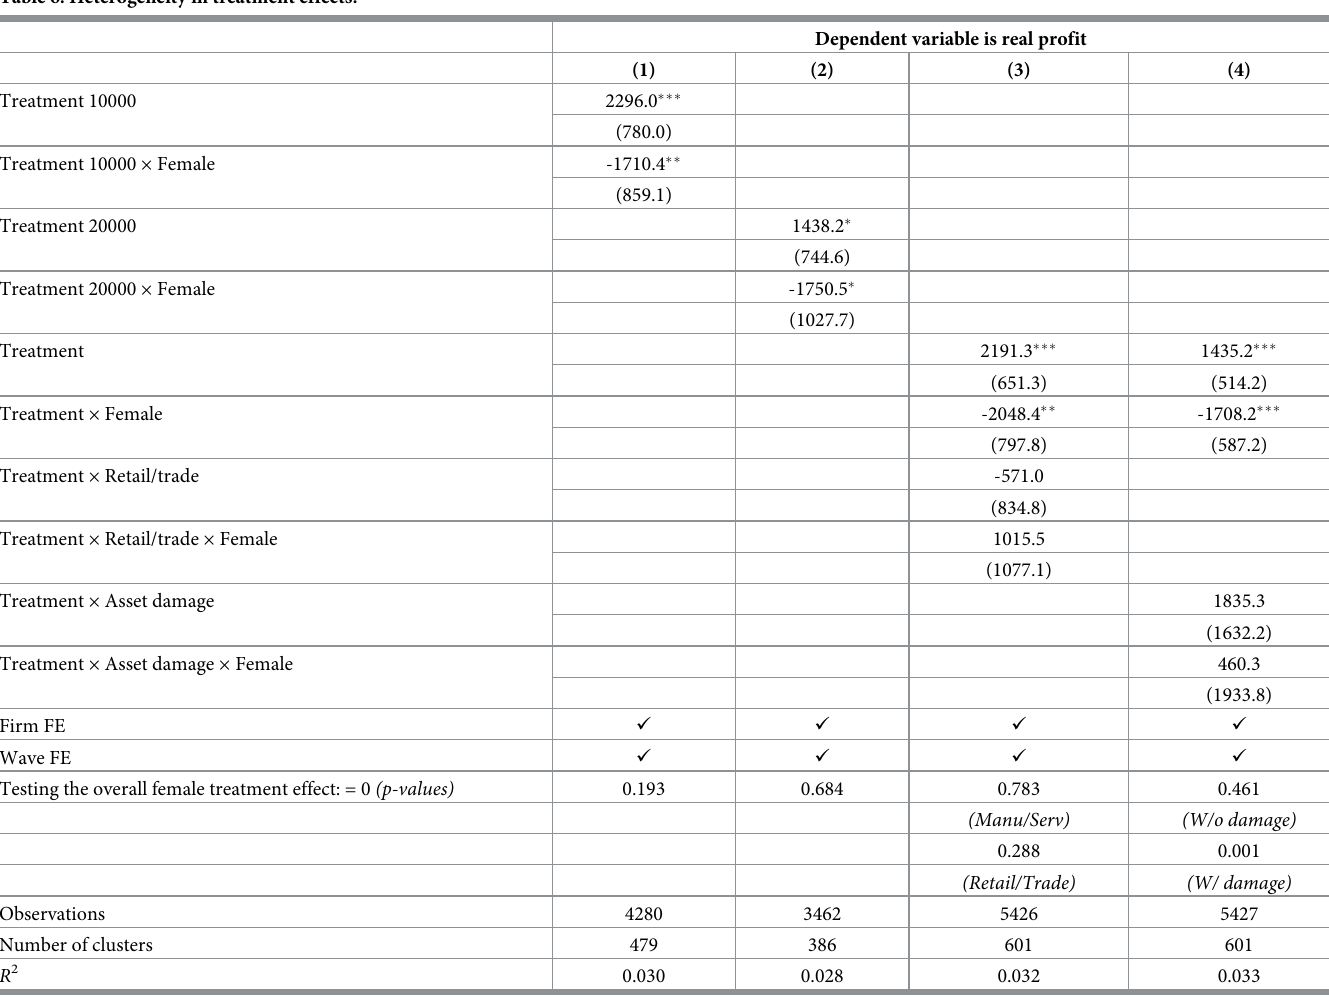
Table 6. Heterogeneity in treatment